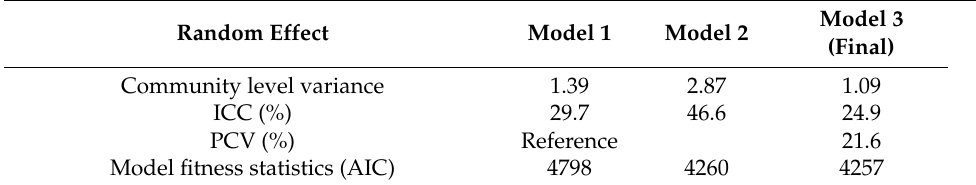
Table A1. Province level variance of the multilevel logistic models predicting acceptance of vaccine in DRC.